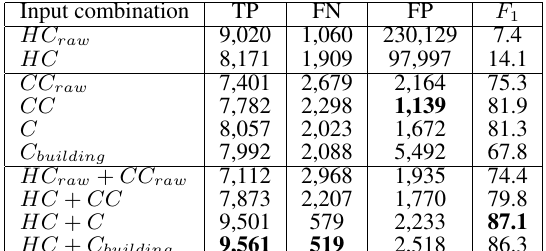
Table 2. Amount of TP, FN and FP pixels as well as F1-scores [%] calculated on raster-level for different inputs at τ = 0 . 5 for the ALS-ALS test set. Best results are marked bold.